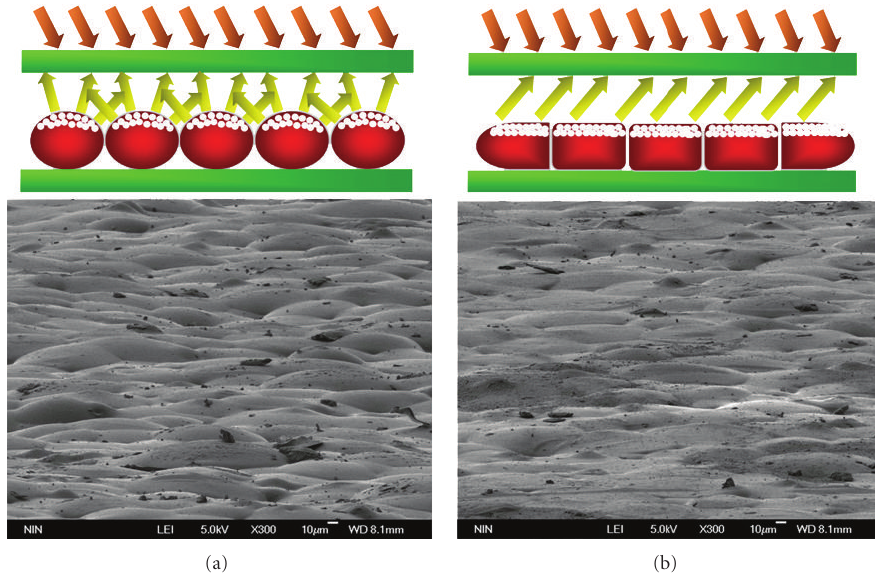
Figure 1: Schematic illustration with di ff erent surface morphology and corresponding SEM images of material display film.